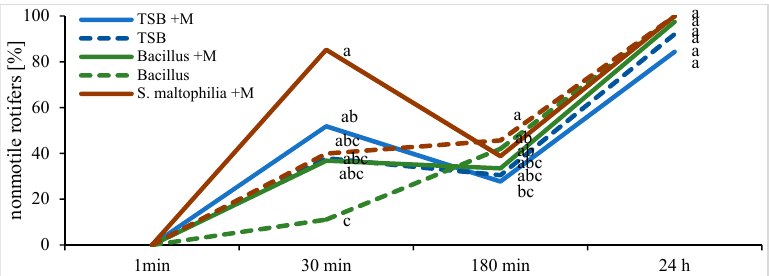
Figure 7. The reaction of the rotifers two hours after the introduction of different concentrations of chitinase; control—no treatment; PBS (phosphate buffered saline) only; the presented results are mean values from five replicates with error bars indicating SD, statistical significance was tested by the one-way analysis of variance (ANOVA) followed by the Tuckey post-hoc test at p ≤ 0.05; bars topped by the same letter (a, b or c) do not differ significantly.